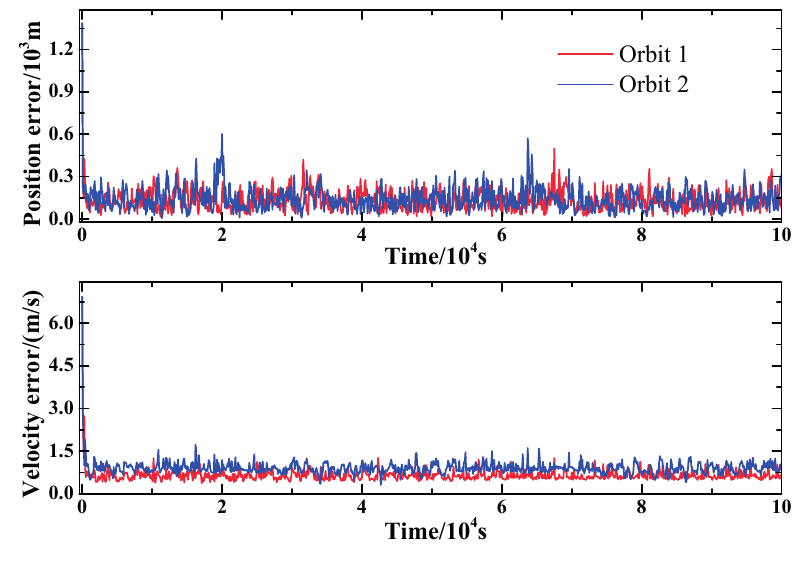
Figure 7. Filtering performance in different